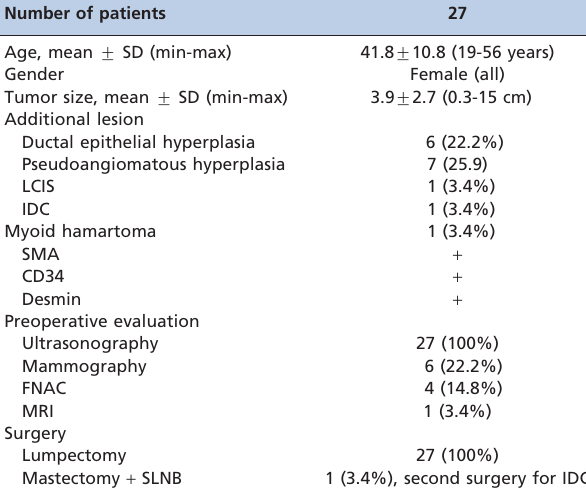
Table 1 - Demographics and clinicopathologic features of 27 patients with breast hamartoma.